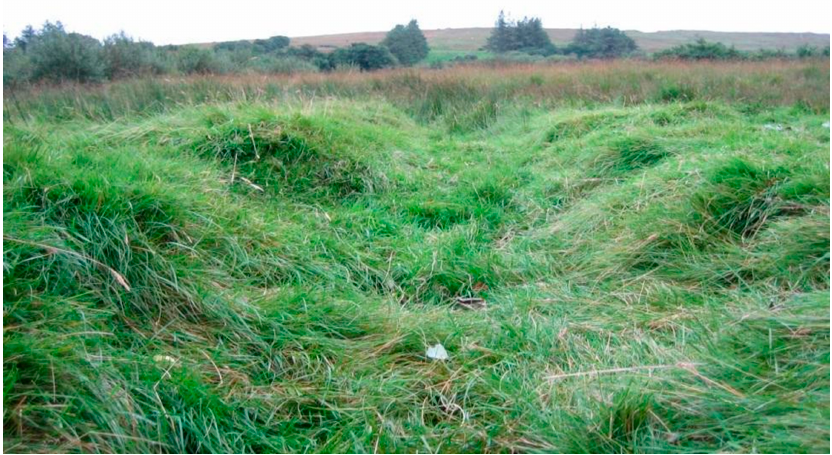
Figure A5. Photograph looking along the seventh